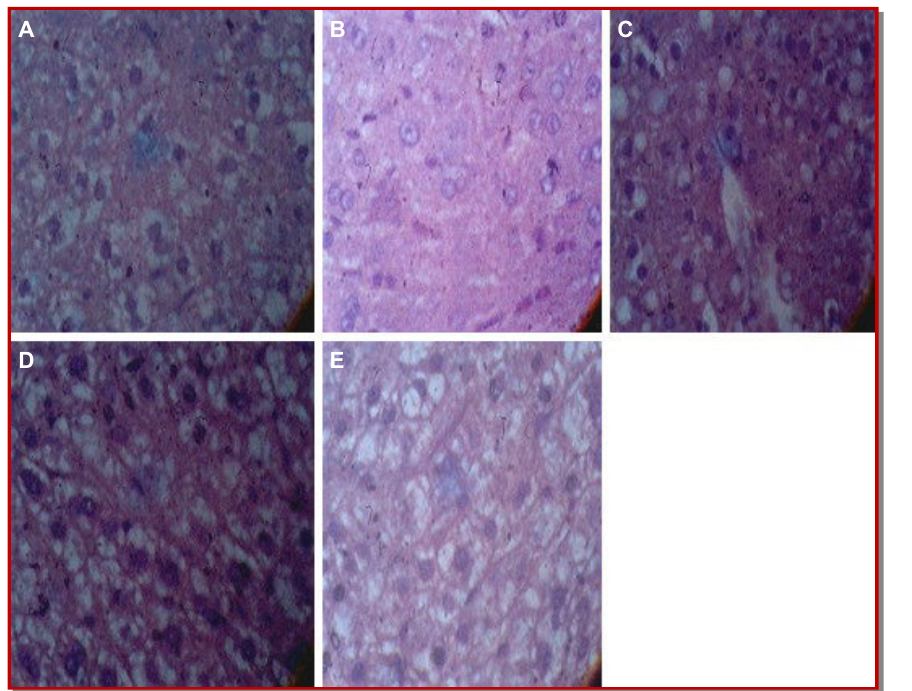
Figure 1: Photograph of architecture of liver in paracetamol-induced hepatotoxicity in rabbits. (A) Liver architecture of normal; (B) Liver architecture of paracetamol-treatment showing inflammation, ballooning degeneration, apoptotic cells, and fibrosis; (C) Liver architecture paracetamol-treatment plus 100 mg/kg silymarin treatment showing limited ballooning degeneration and in- flammation; (D) Liver architecture paracetamol treatment plus extract 500 mg/kg showing reduced ballooning degeneration and inflammation; (E) Liver architecture paracetamol treatment plus 750 mg/kg showing limited area of ballooning degeneration and